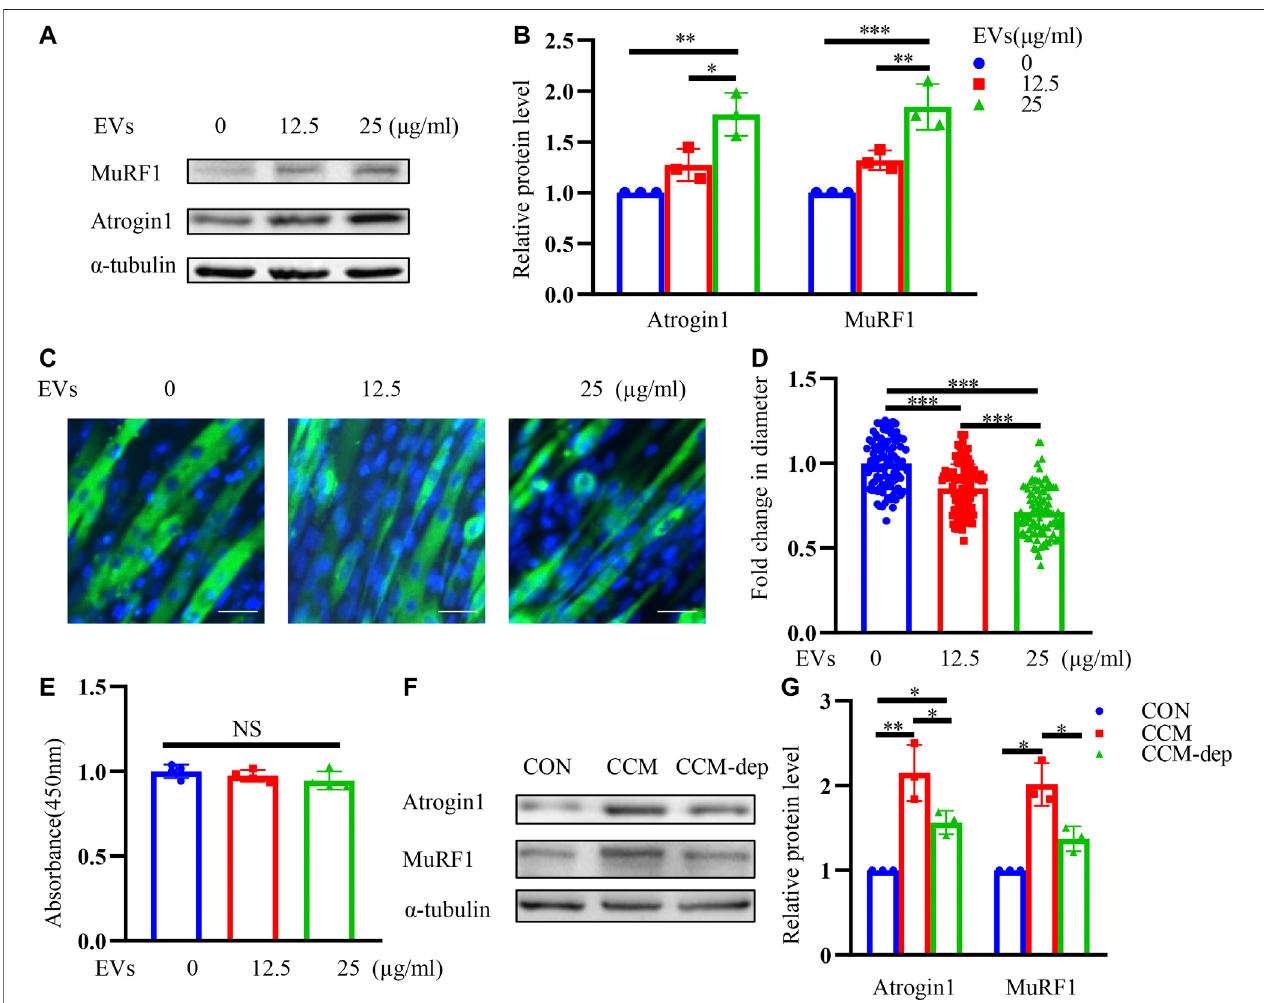
FIGURE 2 | CT26-derived exosomes induce muscle wasting in C2C12 myotubes. (A) Total extracts of C2C12 myotubes treated with different concentrations of CT26-EVs were used for western blotting analysis with antibodies against with Atrogin1, MuRF1 and α -tubulin. (B) Densitometric quanti fi cation of the Atrogin1 and MuRF1 signal relative to the α -tubulin signal. (C) Representative immuno fl uorescence images for C2C12 myotubes treated with different concentrations of CT26-EVs. Scale bar (cid:2) 50 μ m. (D) The relative fi ber widths of C2C12 myotubes treated with different concentrations of CT26-EVs. (E) CCK8 assay for C2C12 myotubes treatedwithdifferentconcentrationsofCT26-EVs. (F) TotalextractsofC2C12myotubestreatedwithCT26-EVsandexosome-depletedconditionedmediumwereused for western blotting analysis with Atrogin1, MuRF1 and α -tubulin. (G) Densitometric quanti fi cation of the Atrogin1 and MuRF1 signal relative to the α -tubulin signal.